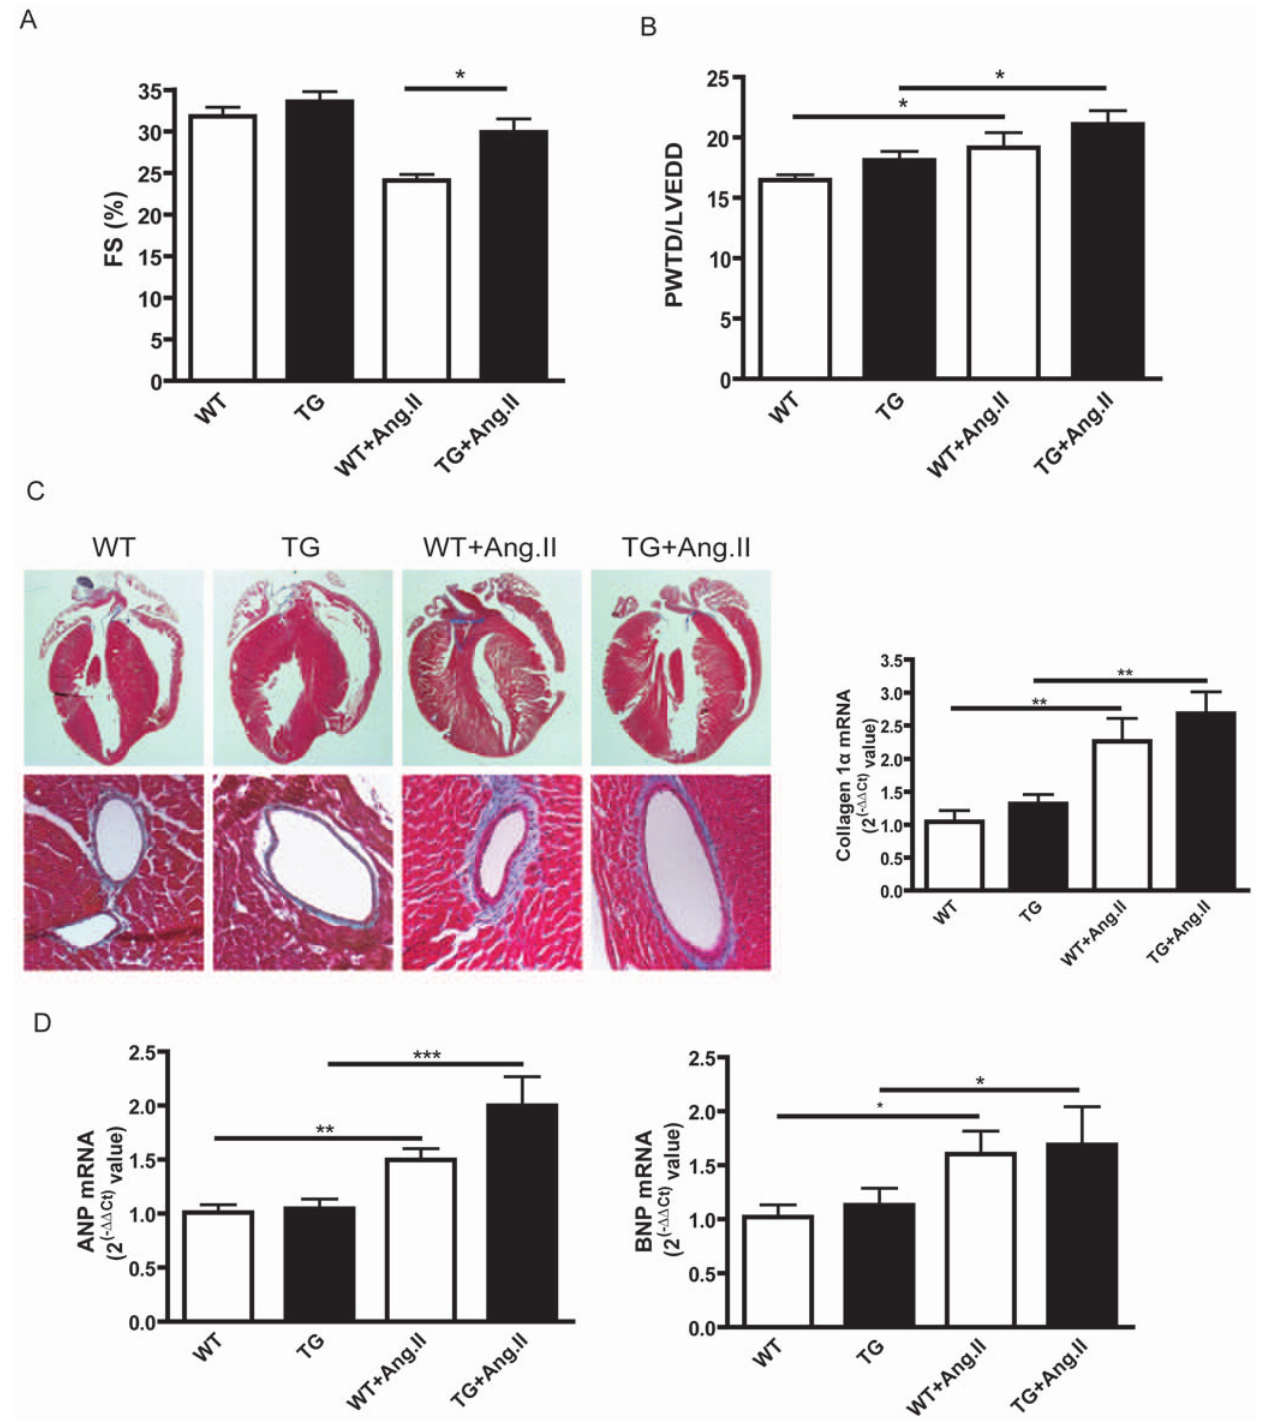
Figure 5. Characterisation of cardiac function, fibrosis and hypertrophy under pressure overload conditions (3.5 months of age). (A, B) Echocardiographic measurements of fractional shortening (A) and interventricular septum diameter in diastole (B) in WT (n=10) and CTGF-TG (n=11) mice treated with Ang II (*p , 0.05; ** p , 0.01, *** p , 0.001) (C) Masson’s trichrome stained cardiac sections of mice treated with Ang II and quantification of collagen 1 a mRNA expression by Taqman-PCR. (D) Quantification of ANP and BNP mRNA expression by TaqMan-PCR in mice treated with Ang II (n=4 per group). doi:10.1371/journal.pone.0006743.g005 last parameters were not found to be changed in transgenic cardiomyocytes. Taken together, overexpression of CTGF in Further, we assayed the Ca 2 + transient amplitude and the velocity of Ca 2 + influx and -efflux from sarcoplasmatic reticulum. Yet, the cardiomyocytes is accompanied by an enhanced Ca 2 + clearance